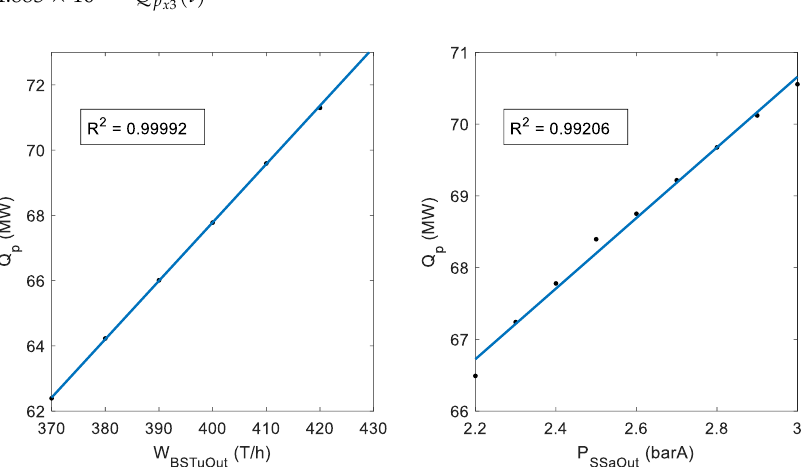
Figure 3. Experiments carried out to show linearity dependence between Q p and W BStOut ( left ) and P SSaOut ( right ).